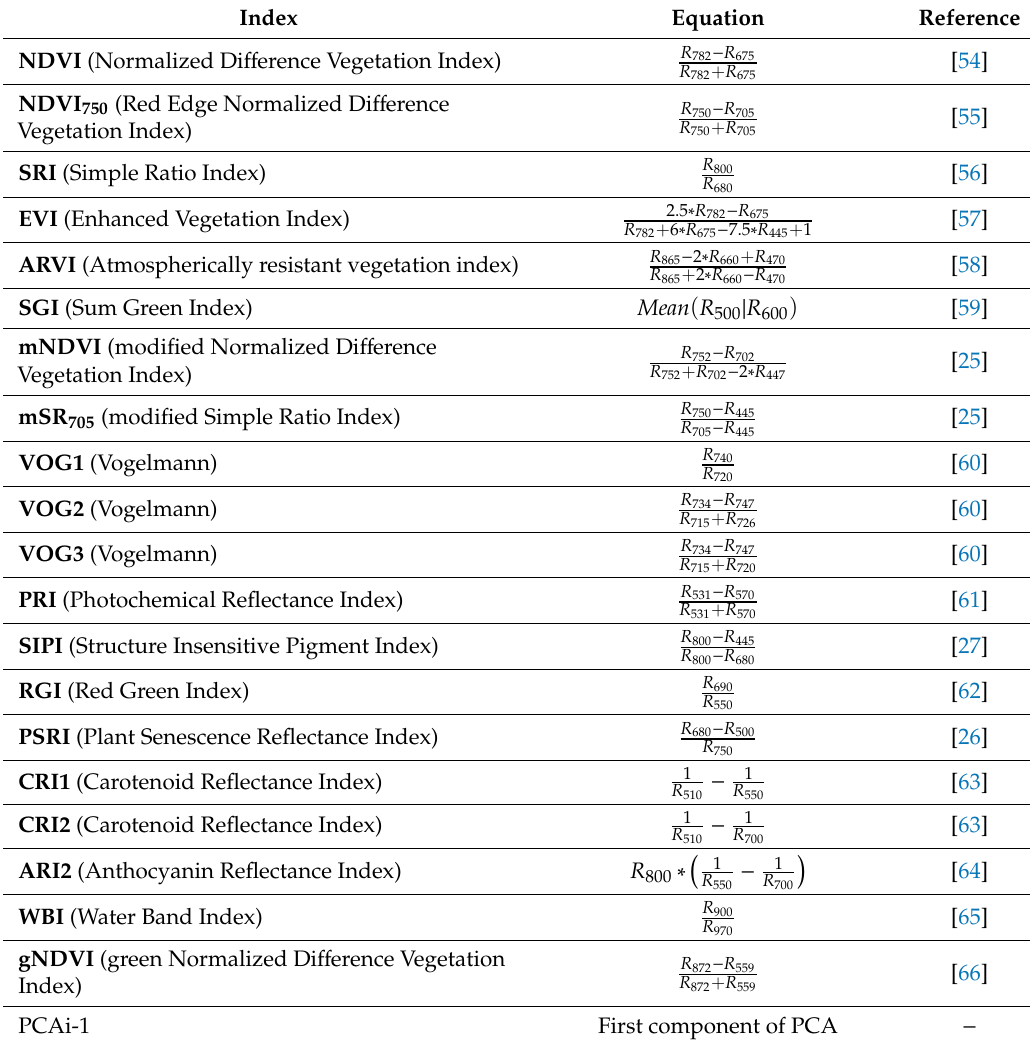
Table 2. Empirical vegetation indices extracted from the hyperspectral data collected with the leaf